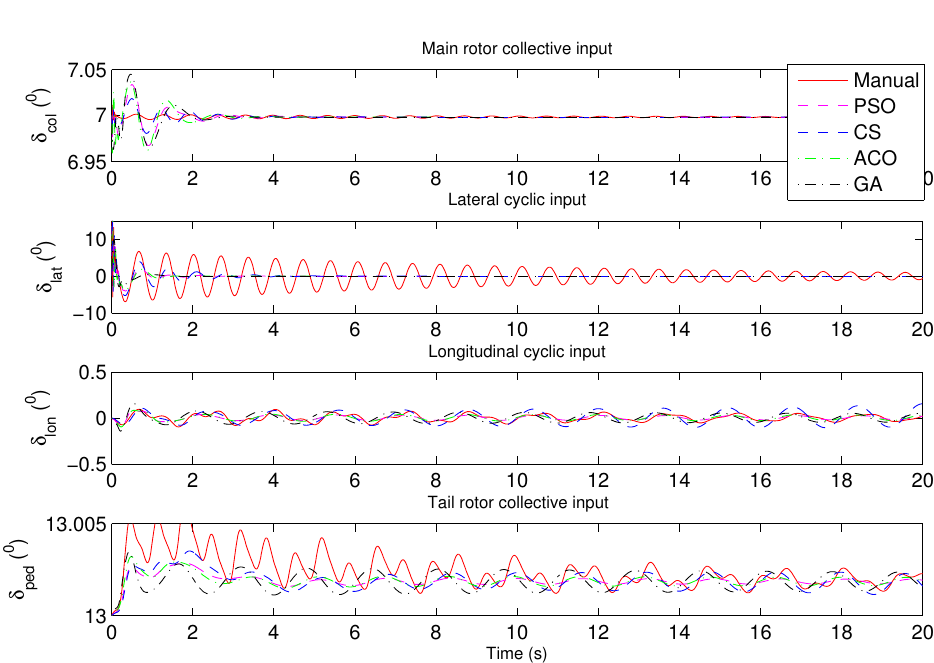
Figure 11. The four rotorcraft inputs to maintain trim hover flight.